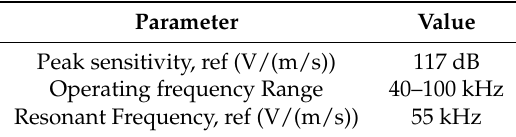
Table 2. Specifications of R6I-AST